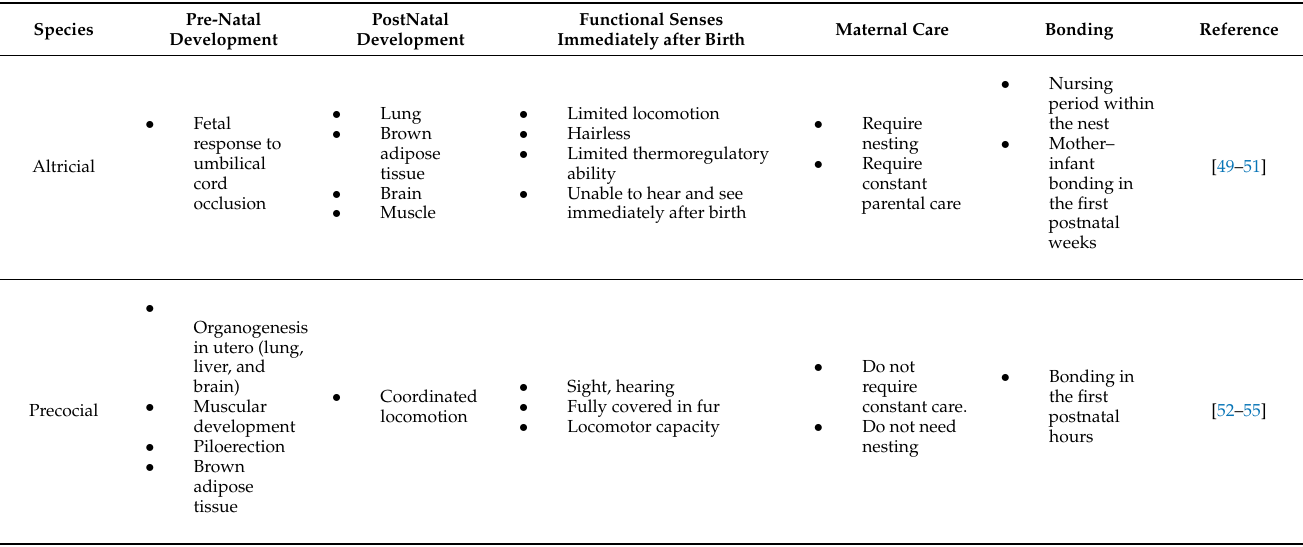
Table 1. Summary and comparison of maternal bonding in altricial and precocial species. PostNatal Functional Senses Development Immediately after Birth Maternal Care Bonding